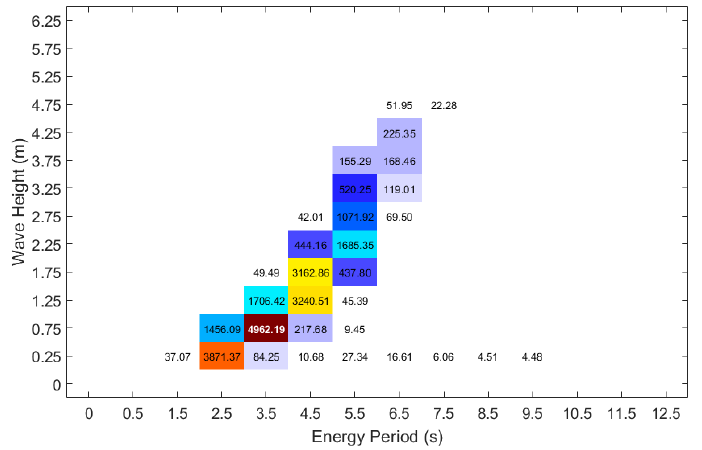
Figure 14. Scatter diagram on the annual energy distribution of the WEC under optimal control. The energy in each square corresponds to the sea state of Site 12.